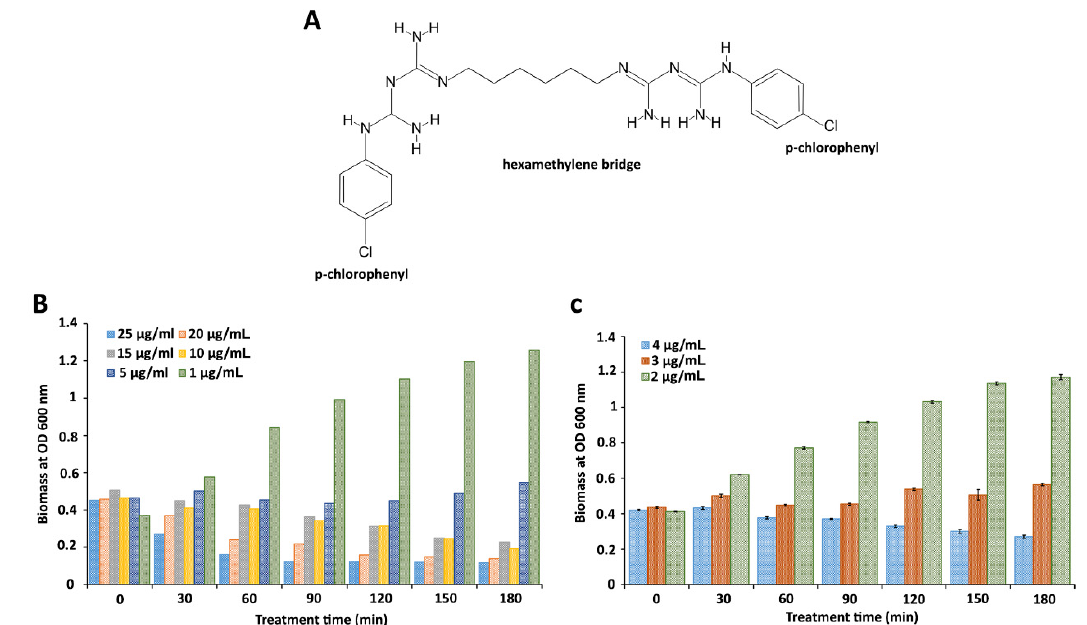
Figure 2. Determination of the MIC of chlorhexidine for the wild-type S. Enteritidis. ( A ) Molecule of chlorhexidine, composed of two p-chlorophenyl rings connected by central hexamethylene bridge. ( B ) Freshly grown S. Enteritidis cultures with an optical density at 600 nm of 0.4 (~1 × 10 8 cell forming units per mL) were treated with a wide range of chlorohexidine concentrations. Viable cell counts are shown for every 30-min treatment during 180 min. Data represent one biological replication. ( C ) The same treatment approach, with a narrow range of chlorhexidine concentrations (2, 3, and 4 µg/mL), was used in combination with three biological replications. The error bars indicate the standard errors of the means.